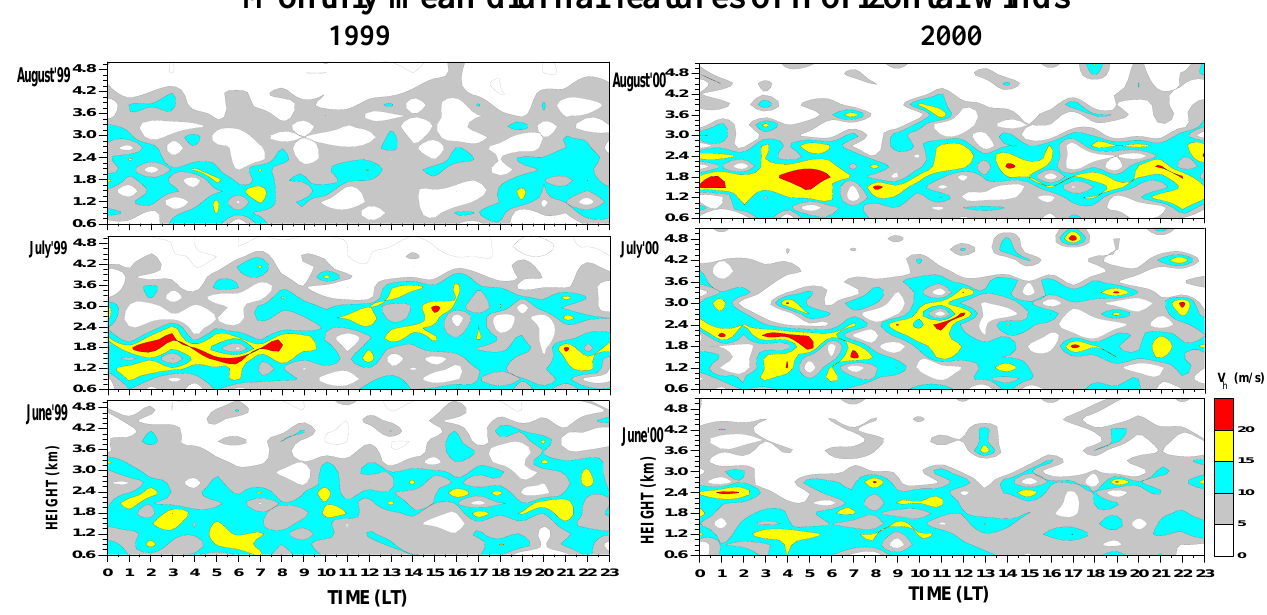
Fig. 6a. (Left and right) Mean monthly diurnal features of horizontal wind contours for June (bottom), July (middle) and August (top) for 1999 and